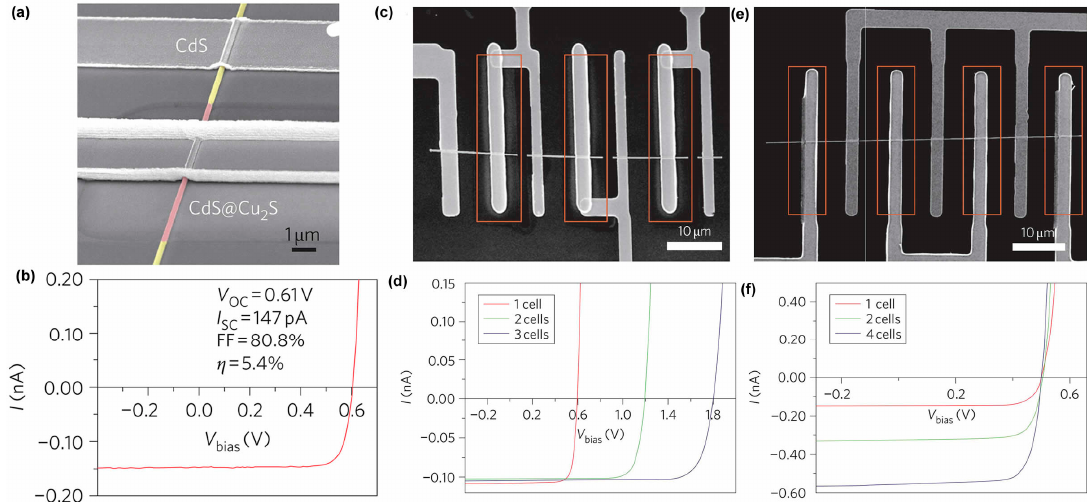
Figure 10. ( a ) SEM image of a PV unit; CdS and Cu 2 S are highlighted with yellow and brown false colours, respectively. ( b ) I-V characteristic of a core-shell nanowire under 1 sun (AM 1.5 G) illumination. ( c ) SEM image of three PV units from a single nanowire in series with the core-shell regions marked by the brown rectangles. ( d ) I-V characteristic of the in series units under 1 sun illumination (AM 1.5 G), showing that the voltages add and the current remains fixed. ( e ) SEM image of four PV units from a single nanowire in parallel with the core-shell regions marked by the brown rectangles. ( f ) I-V characteristic of the four units in parallel under 1 sun illumination (AM 1.5 G), showing that the currents add and the voltage remains fixed. Reproduced with permission from [9], Copyright 2011, Nature Publishing